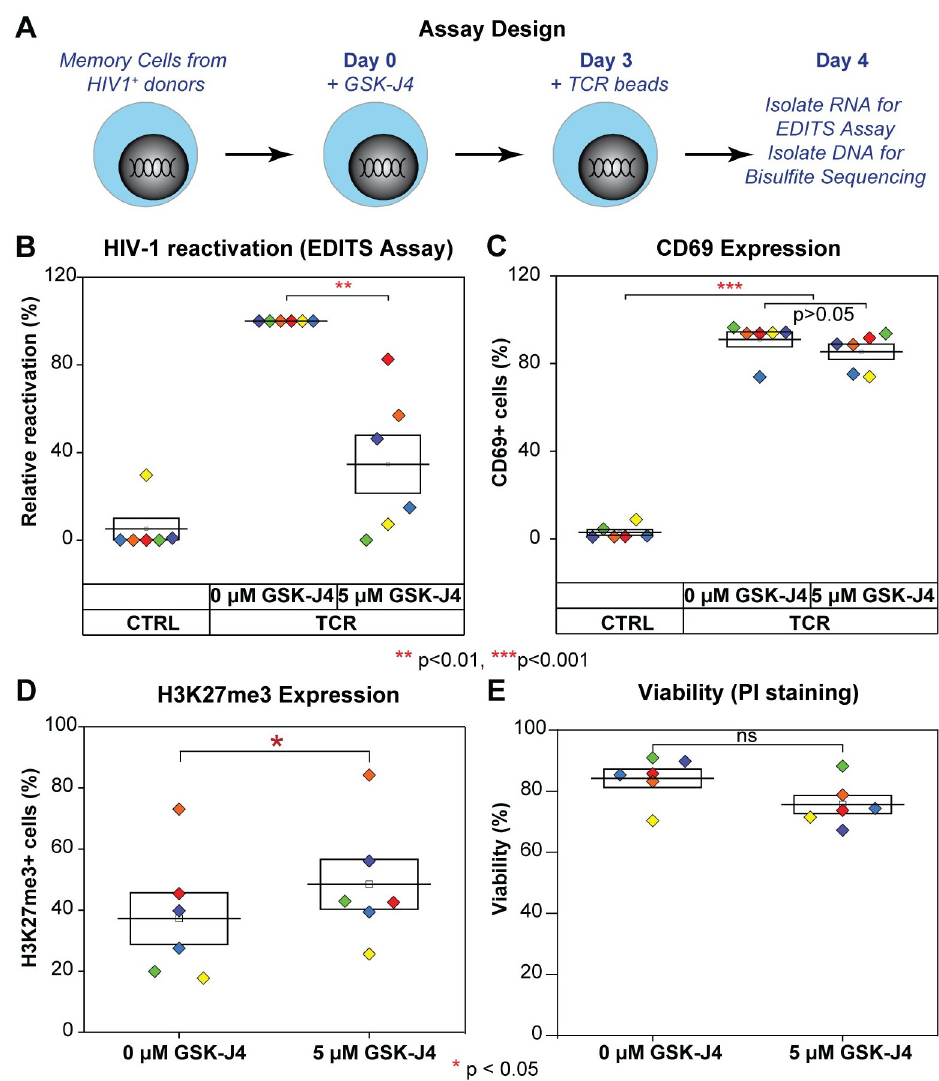
Fig 7. GSK-J4 inhibits reactivation of latent HIV-1 in CD4 memory T cells isolated from well suppressed HIV-1 infected donors. (A) Schematic diagrams describing the experimental designs. (B) Inhibition of latent HIV-1 reactivation in CD4+ memory T cells from HIV-1 infected patients on cARTs by UTX inhibitor. CD4+ memory T cells isolated from HIV-1 infected patients were treated for 3 days with indicated concentrations of GSK-J4. Cells were left untreated or further treated with human T-Activator CD3/CD28 Dynabeads overnight. Levels of spliced HIV-1 env mRNA were measured by EDITS assays. Levels of relative reactivation were normalized to the levels of spliced HIV-1 env mRNA induced by human T-Activator CD3/CD28 Dynabeads (presented as 100%) for each donor. (C) Expression levels of CD69 from treated CD4+ memory T cells measured by FACS using CD69 antibody. One-way ANOVA p < 0.005, Bonferroni posttests � p < 0.05 �� p < 0.01 ��� p < 0.001 were performed for both Fig 7B & 7C. (D) Intracellular H3K27me3 levels of treated CD4+ memory T cells measured by FACS using a H3K27me3 antibody. Cells were stained with Alexa Fluor 647-conjugated trimethyl histone H3 (Lys27) antibody (12158, Cell Signaling) and analyzed by FACS as described previously [22]. (E) Viability of cells by PI staining. After drug treatment, cells were stained with PI at the final concentration of 5 μ g/ml for 5 minutes, then analyzed by FACS. Two-tailed paired t-test was performed for both Fig 7D & 7E, � p < 0.05, ns: not statistically significant.